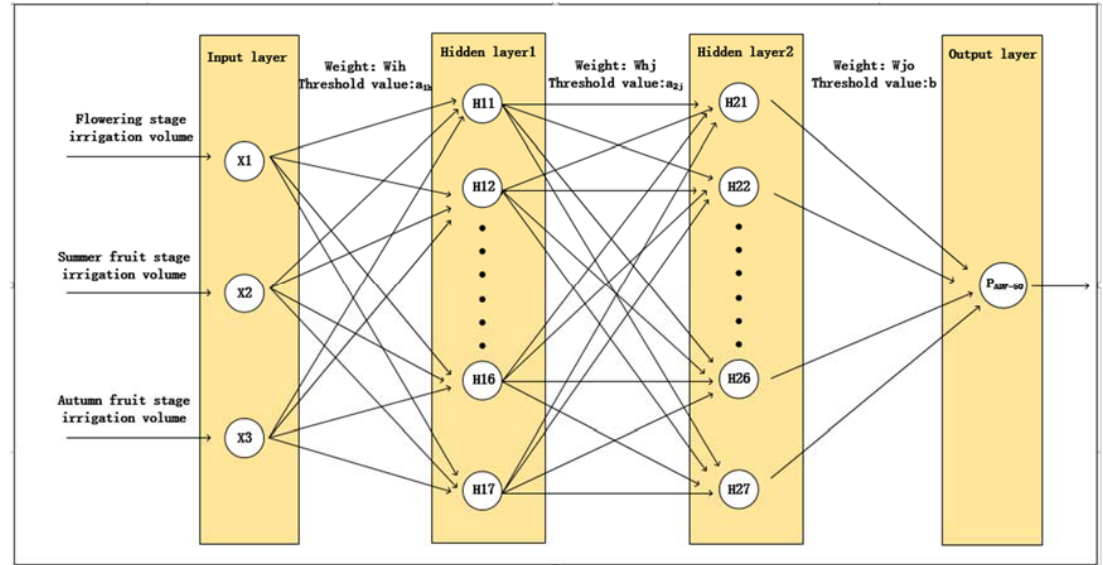
Figure 2. Structure diagram of ADF-50 neural network model.